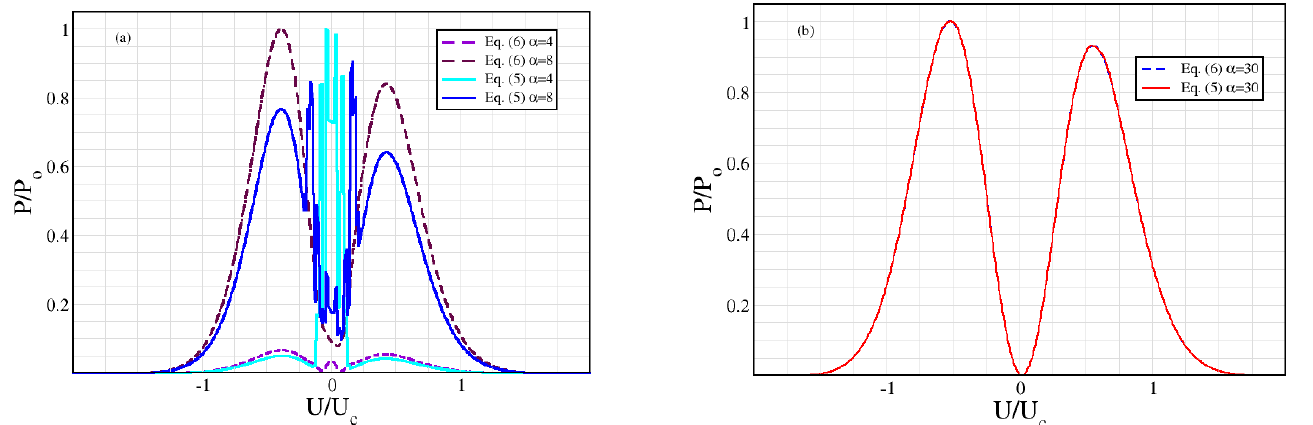
Figure 4. Comparison between the Second Harmonic power output, with an input frequency ν = 120 GHz using either Equation (5), shown as solid curves, or Equation (6), shown as dashed curves. In panel ( a ) For Equation (5) α = 4 in cyan and α = 8 in blue. For Equation (6), α = 4 in violet and α = 8 in maroon. In panel ( b ) α = 30: dashed blue for Equation (6) and solid red for Equation (5). The current flow asymmetry for all curves is δ = 1.1. U c is the same as in Figure 1. There is almost no difference between both approaches for large α and a large difference for very small α . The calculations presented here are consistent with the experiments in Ref. [47].